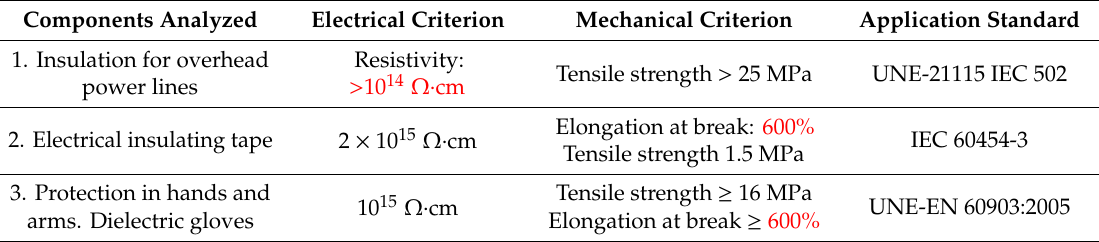
according to the applicable